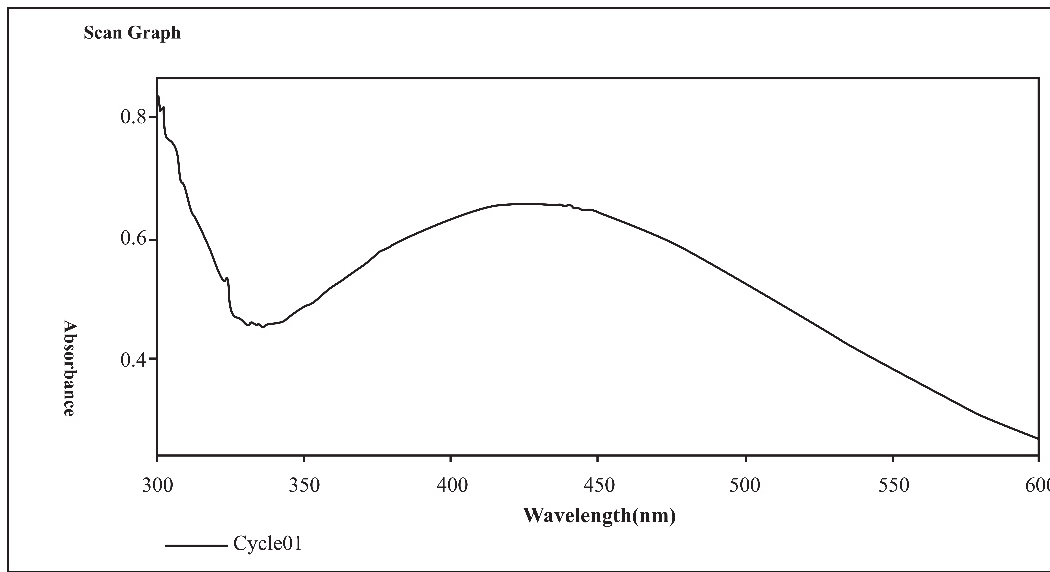
FIGURE 1 - UV-Visible Spectroscopy of M. arvensis Linn. mediated silver nanoparticles. [Absorbance recorded between 300 and 600 nm; Appearance of SPR band at 430